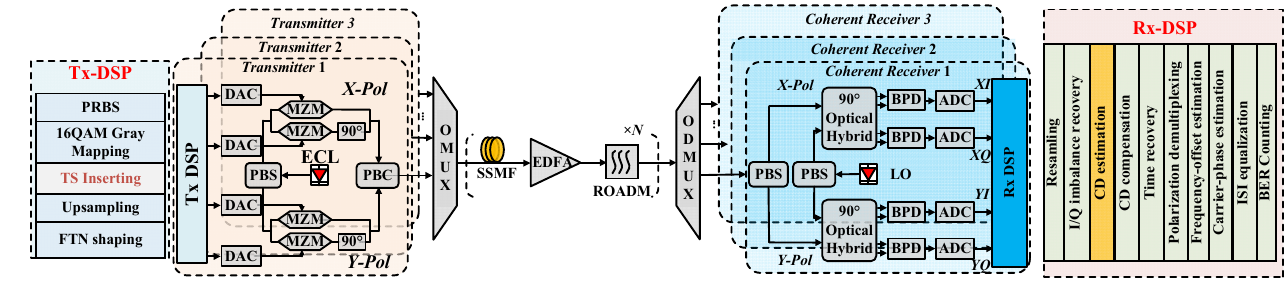
Figure 3. Simulation platform for a 64Gbaud DP-16QAM FTN-WDM system with the proposed CD estimation scheme .